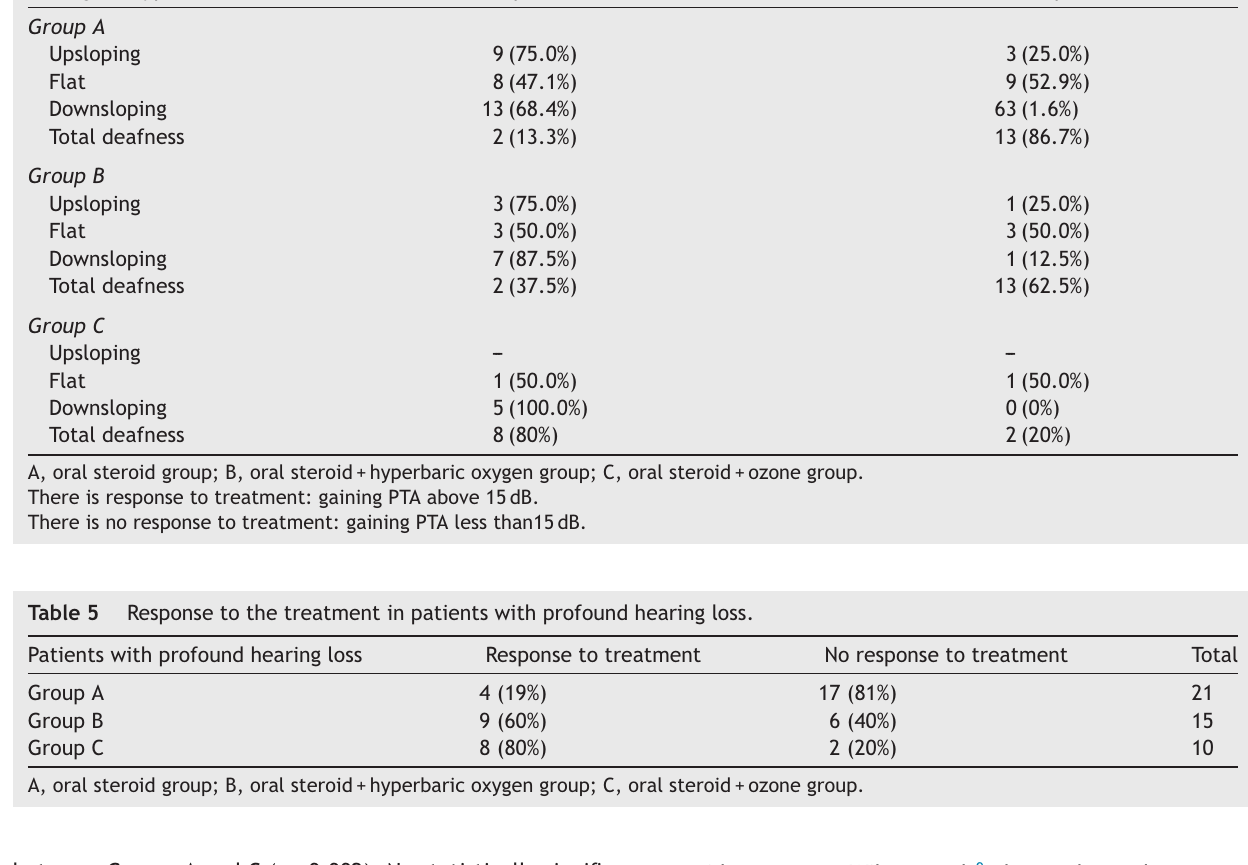
The groups’ response to treatment according to audiogram shape. Audiogram type